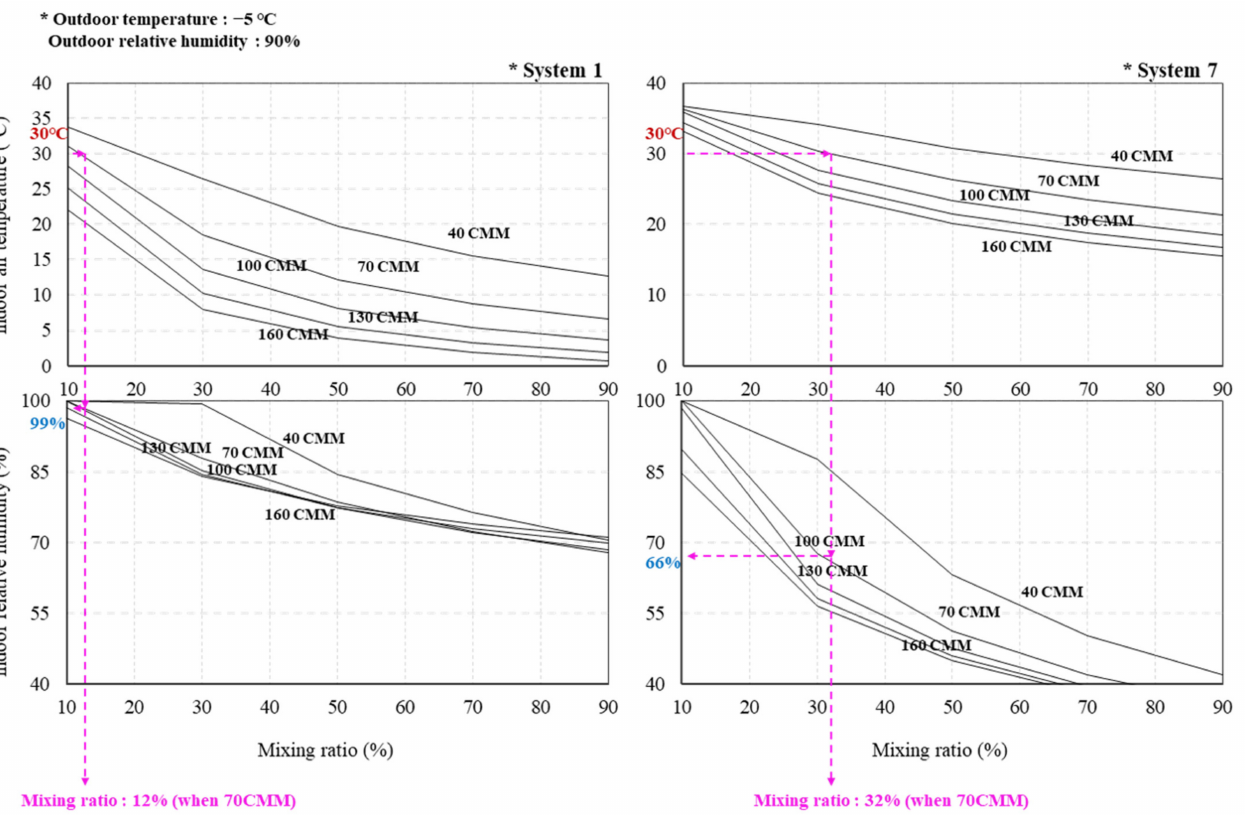
Figure 11. Example of an optimal operation method for ARVS (System 1,